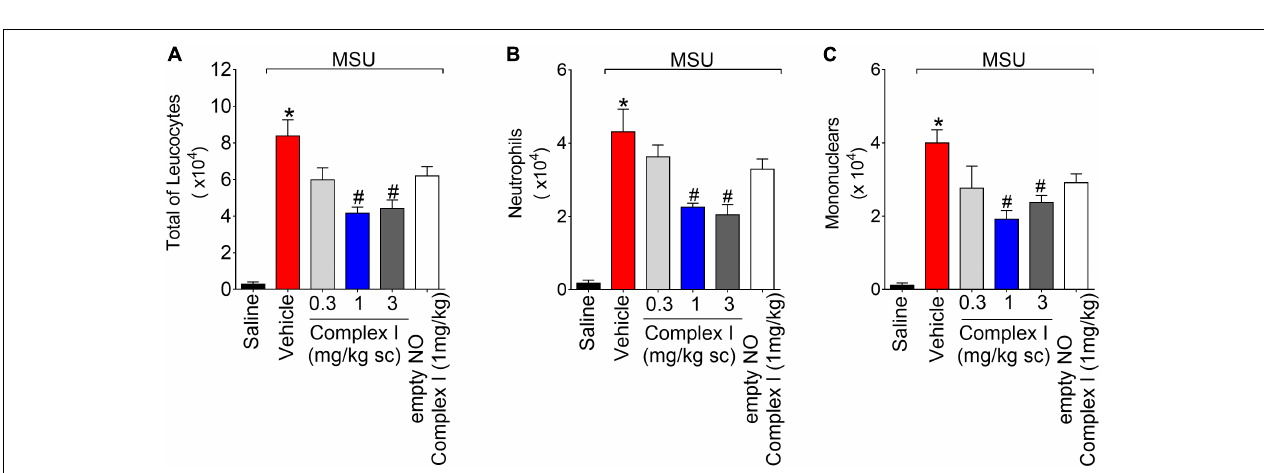
FIGURE 1 | Ruthenium NO donor [Ru(bpy) 2 (NO)SO 3 ](PF 6 ) (complex I) inhibits MSU-induced mechanical hypersensitivity and joint edema. Mice were treated with complex I (0.3, 1, or 3 mg/kg/saline, s.c.) or empty NO complex I (1 mg/kg/saline, s.c.) or vehicle 30 min prior to intra-articular stimulation with MSU (100 µ g/10 µ l). Mechanical hypersensitivity (A) and Edema (B) were evaluated at the intervals of 1, 3, 5, 7, and 15 h after the stimulus with MSU. Results are expressed as mean ± SEM ( n = 6 per group per experiment, representative of two experiments). ∗ p < 0.05 compared to saline group and # p < 0.05 compared to MSU + vehicle. Two-way ANOVA followed by Tukey’s test.